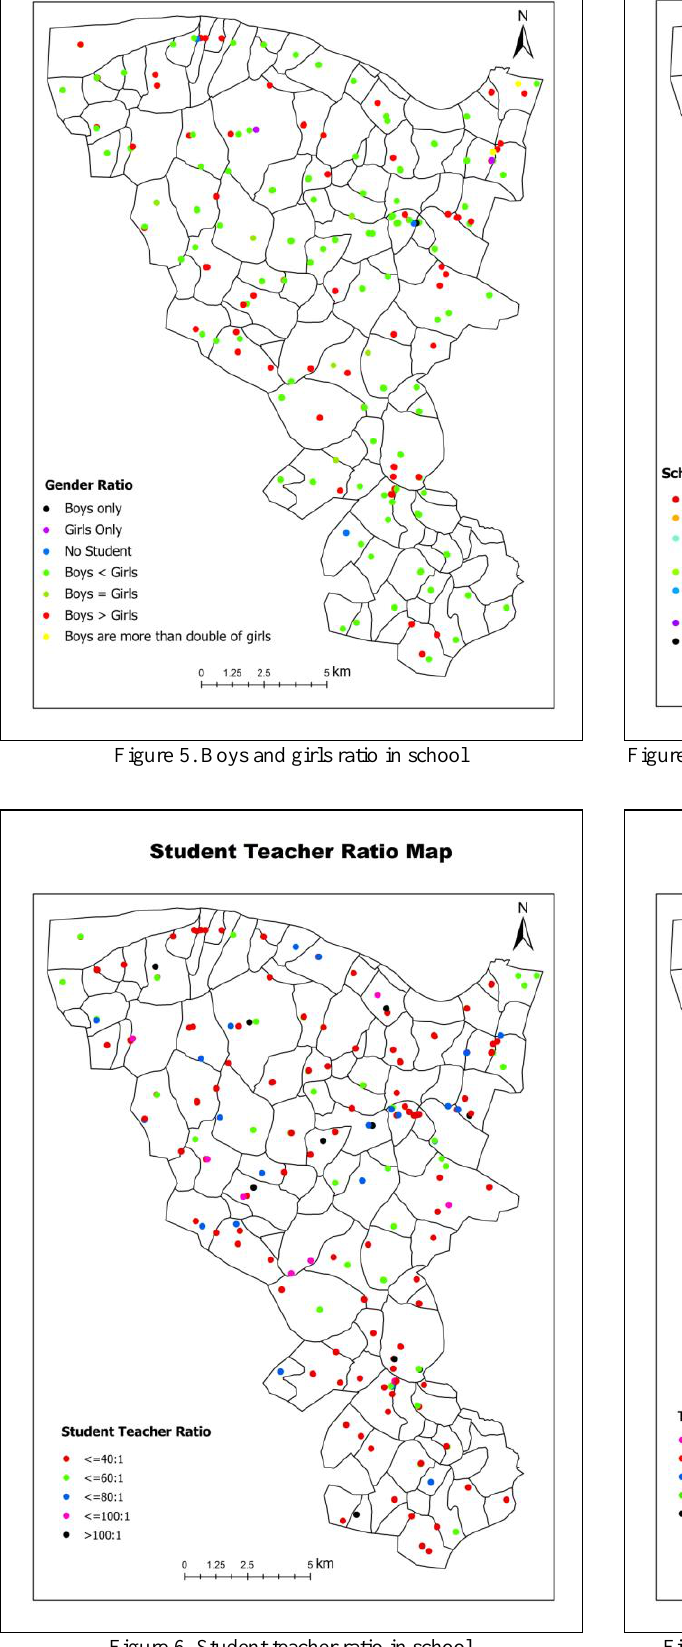
Figure 6. Student teacher ratio in school